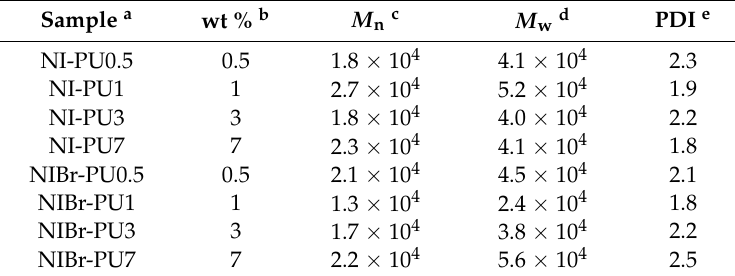
Table 1. GPC Data of NI-PU and NIBr-PU films.